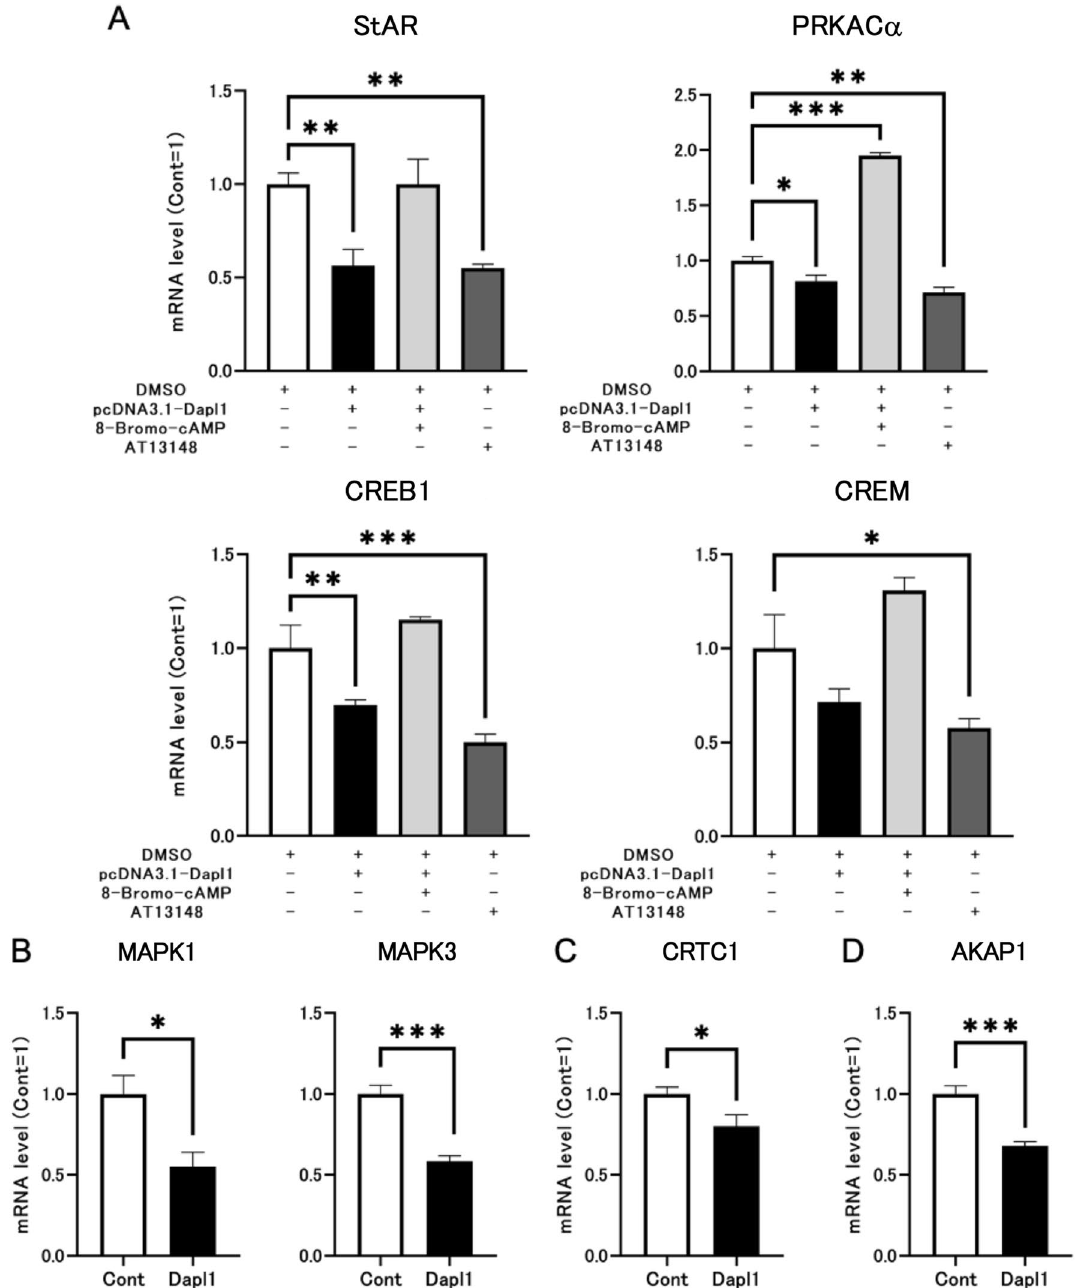
Figure 7. Effects of Dapl1 transfection on the PKA-CREB/CREM-StAR pathway in I-10 cells. (;) The effect of Dapl1 transfection and PKA modulating agents on the PKA system and CREB/CREM pathway gene-expression of mRNA coding for StAR, PRKACα, CREB1, and CREM in I-10 cells. We used an empty plasmid to transfect the "pcDNA3.1- Dapl1 (−)" group of cells, and used the pcDNA3.1-mouse Dapl1 expression plasmid to transfect the "pcDNA3.1- Dapl1 (+)" group of cells. After transfection, the samples were incubated for 48 h, and the related drugs dissolved in DMSO were added. Among them, only the “pcDNA3.1- Dapl1 (−)” group sample with DMSO solvent was added as a control group. Each bar represents the mean ± S.E.M. of 3–4 samples. ( B ) Effect of Dapl1 transfection on the MAPK/ERK pathway gene-expression of mRNA coding for MAPK1 and MAPK3 in I-10 cells. Details of transfection are described in the legend to Fig. 5 and the Material and Methods. Each bar represents the mean ± S.E.M. of 5–6 samples. ( C ) Effect of Dapl1 transfection on the CREB/CREM pathway gene-expression of mRNA coding for CRTC1 in I-10 cells. Each bar represents the mean ± S.E.M. of 5–6 samples. ( D ) Effect of Dapl1 transfection on the gene-expression of mRNA coding for AKAP1 in I-10 cells. Each bar represents the mean ± S.E.M. of 5–6 samples. Significantly different from the control I-10 cells: *p < 0.05, **p < 0.01, ***p < 0.001. DAPL1 death-associated protein-like 1, StAR steroidogenic acute regulatory protein, PKA protein kinase A, CREB cyclic AMP-response element-binding protein, CREM CRE modulator protein, CRTC1 CREB-regulated transcription coactivator 1, AKAP1 A-kinase anchor protein 1, MAPK mitogen-activated protein